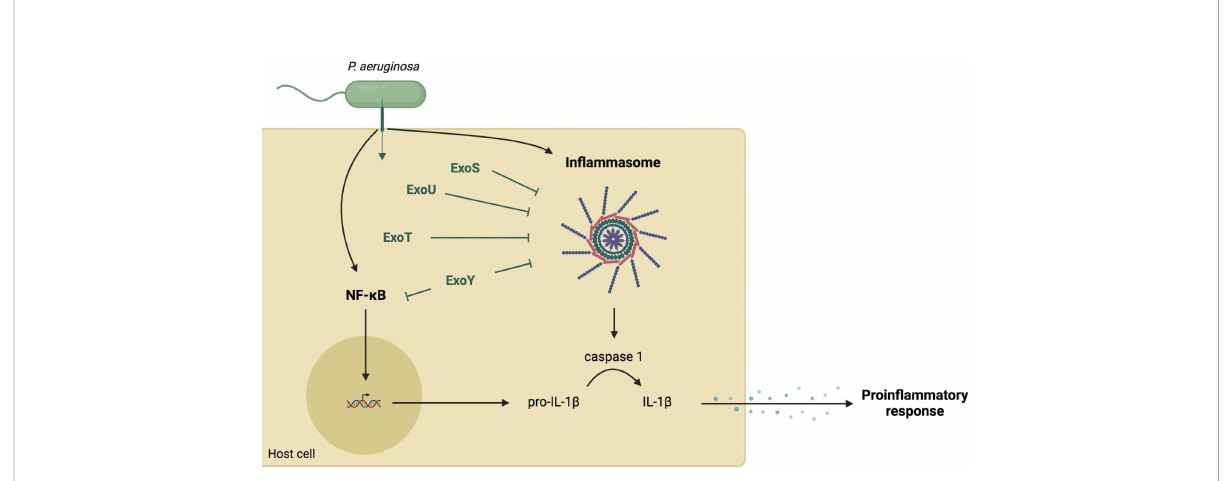
FIGURE 2 Role of T3SS in the cytokine IL-1 b -dependent-proin fl ammatory response. Several components of the needle structure and the translocation apparatus activate the NF- k B pathway leading to the expression of pro-IL-1 b (Grandjean et al., 2017; Yu et al., 2020). They also activate the in fl ammasome pathway resulting in a caspase-1-dependent maturation of IL-1 b (Grandjean et al., 2017; Dortet et al., 2018). This cytokine production allows the recruitment of immune cells. However, injected exotoxins (in green) can inhibit both NF- k B and in fl ammasome pathways through various